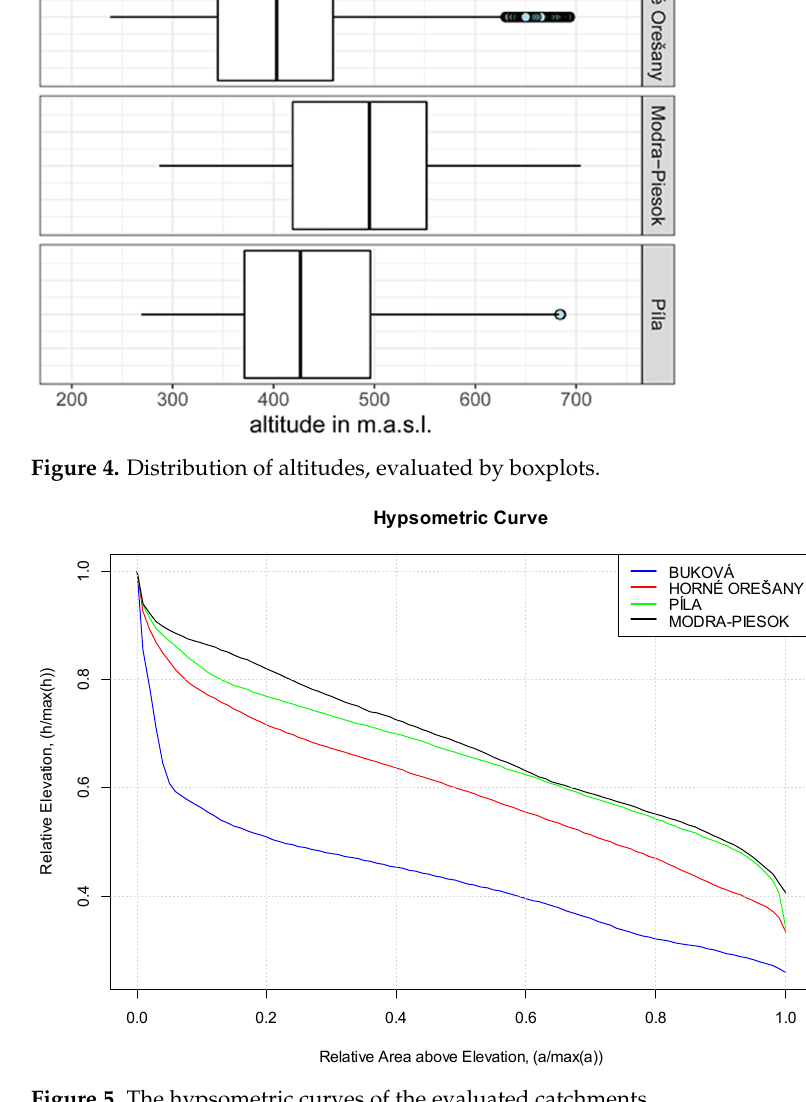
Figure 5. The hypsometric curves of the evaluated Figure 5 . The hypsometric curves of the evaluated catchments The boxplots of the slopes (Figure 6) show a similar distribution of values in the Bu- ková, Horné Orešany and Píla catchments; the most frequent slope has a value of around 9°. The Modra-Piesok catchment distribution of slope values shows the smallest standard deviation in the set, i.e., 4.46, and the highest skewness (Table 3), so it was evaluated as the most dissimilar to the rest of the evaluated catchments from this point of view (and it is penalized in Table 6).